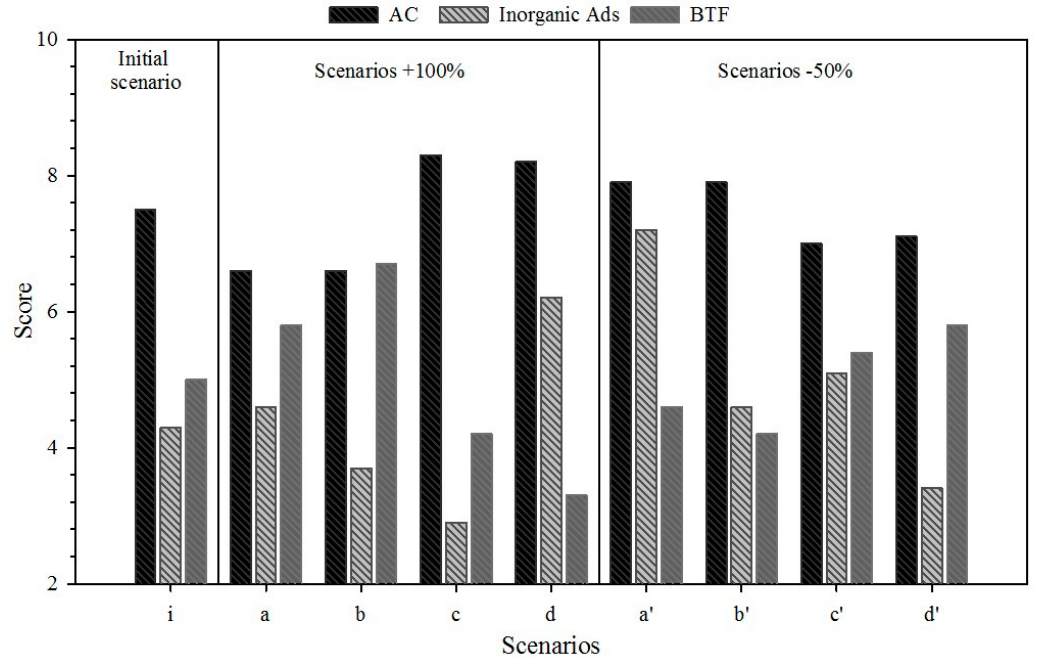
Figure 5. Scores resulting from the sensitivity analysis in the scenarios described in Table 4 for selected siloxane removal technologies (activated carbon, inorganic adsorbents and biotrickling filter).